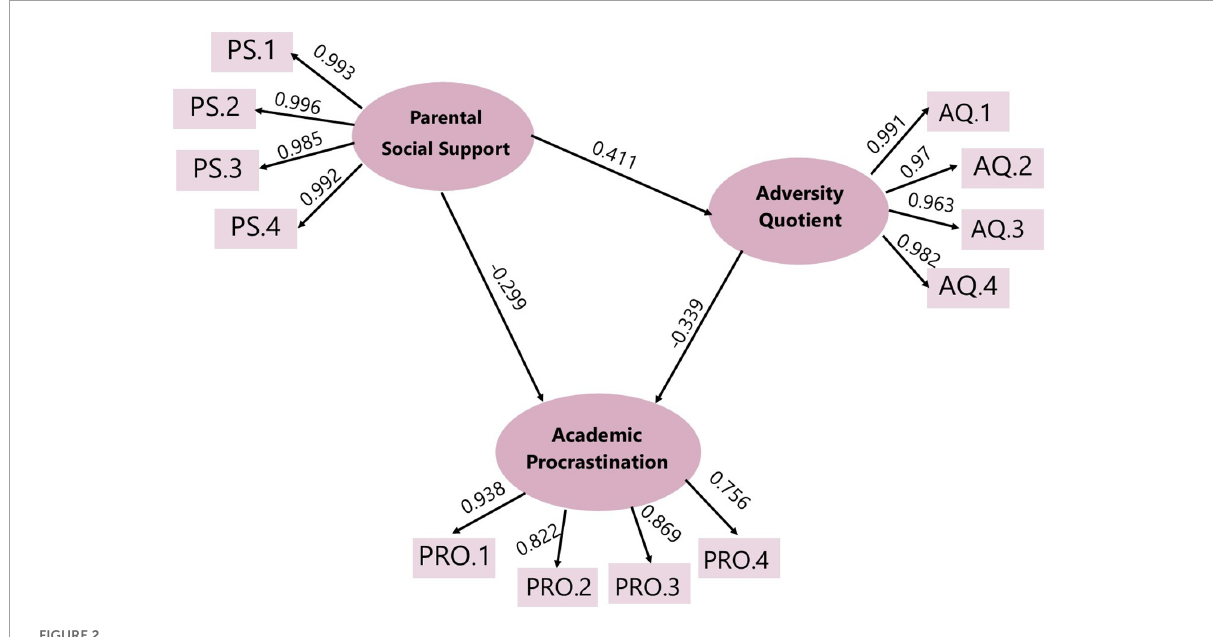
FIGURE2 Parental social support-adversity quotient-academic procrastination model.